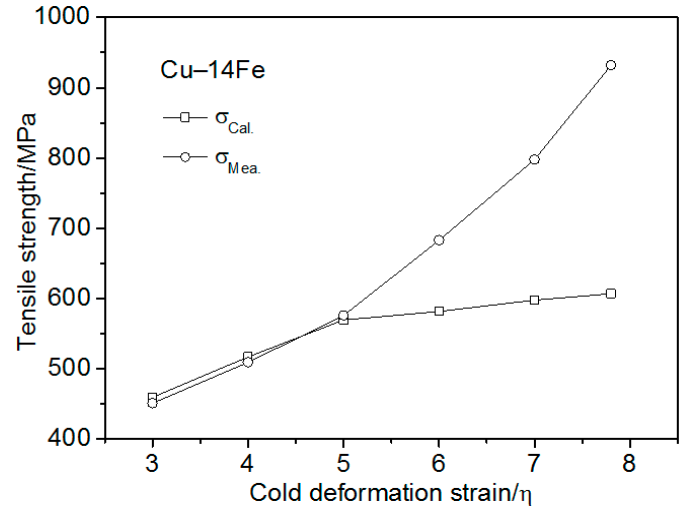
Figure 9. Cu–14Fe strength as-measured and calculated using the improved ROM vs. the cold deformation strain.